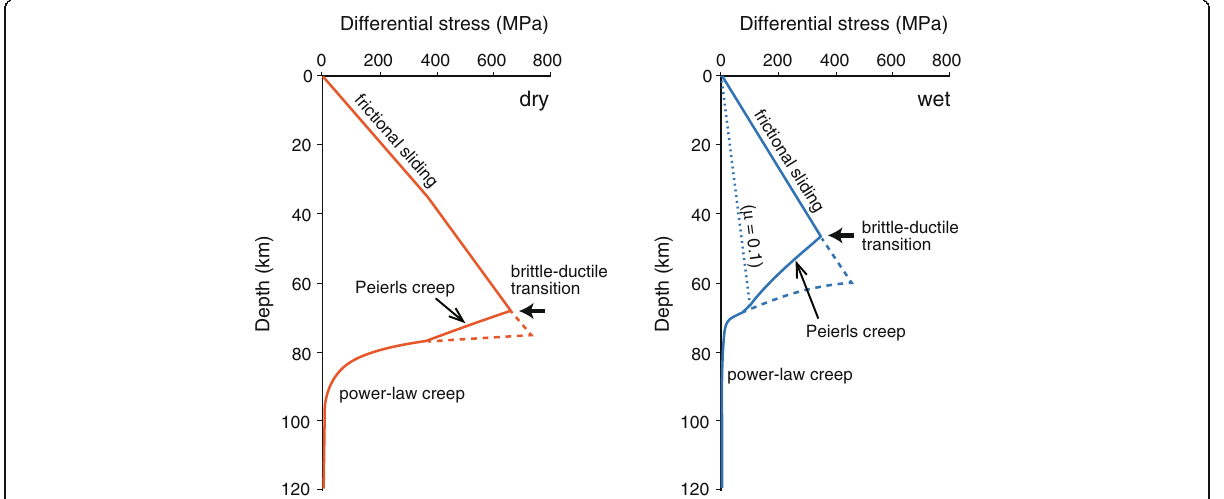
Fig. 1 Strength profile of the lithosphere under dry and wet conditions, calculated using a constant thermal gradient of 8 K/km and strain-rate of 10 − 19 s − 1 . At shallow depths, deformation is mainly accommodated by frictional sliding, and at greater depths, deformation is accommodated by plastic deformation. Peierls creep becomes dominant at depth close to the brittle-ductile transition, resulting in a thinner elastic thickness than that calculated using power-law